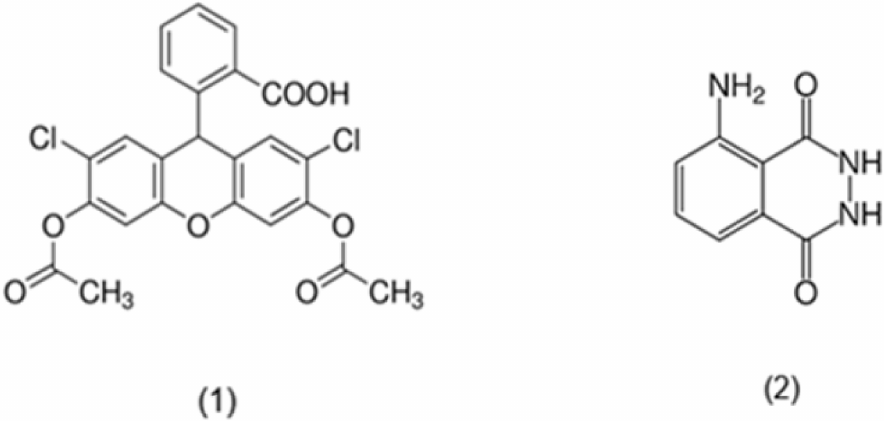
Figure 4. ( 1 ) Dihydrofluorescein diacetate; ( 2 )